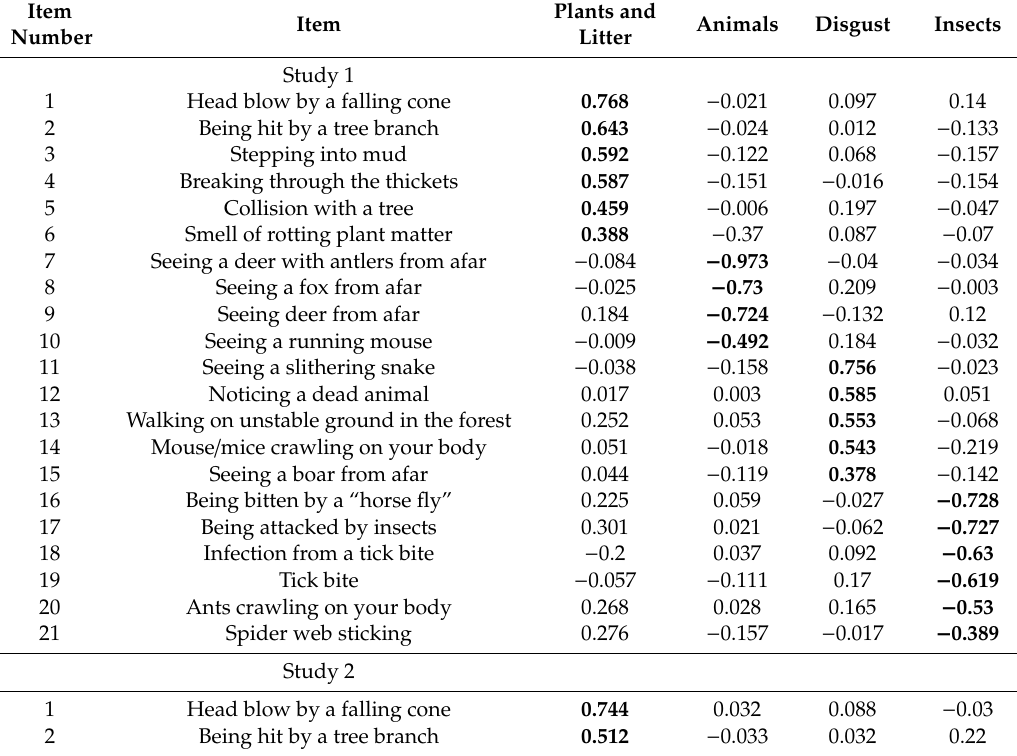
Table 3. Rotated factor pattern matrix for the Anti-Environmental Forest Experience Scale